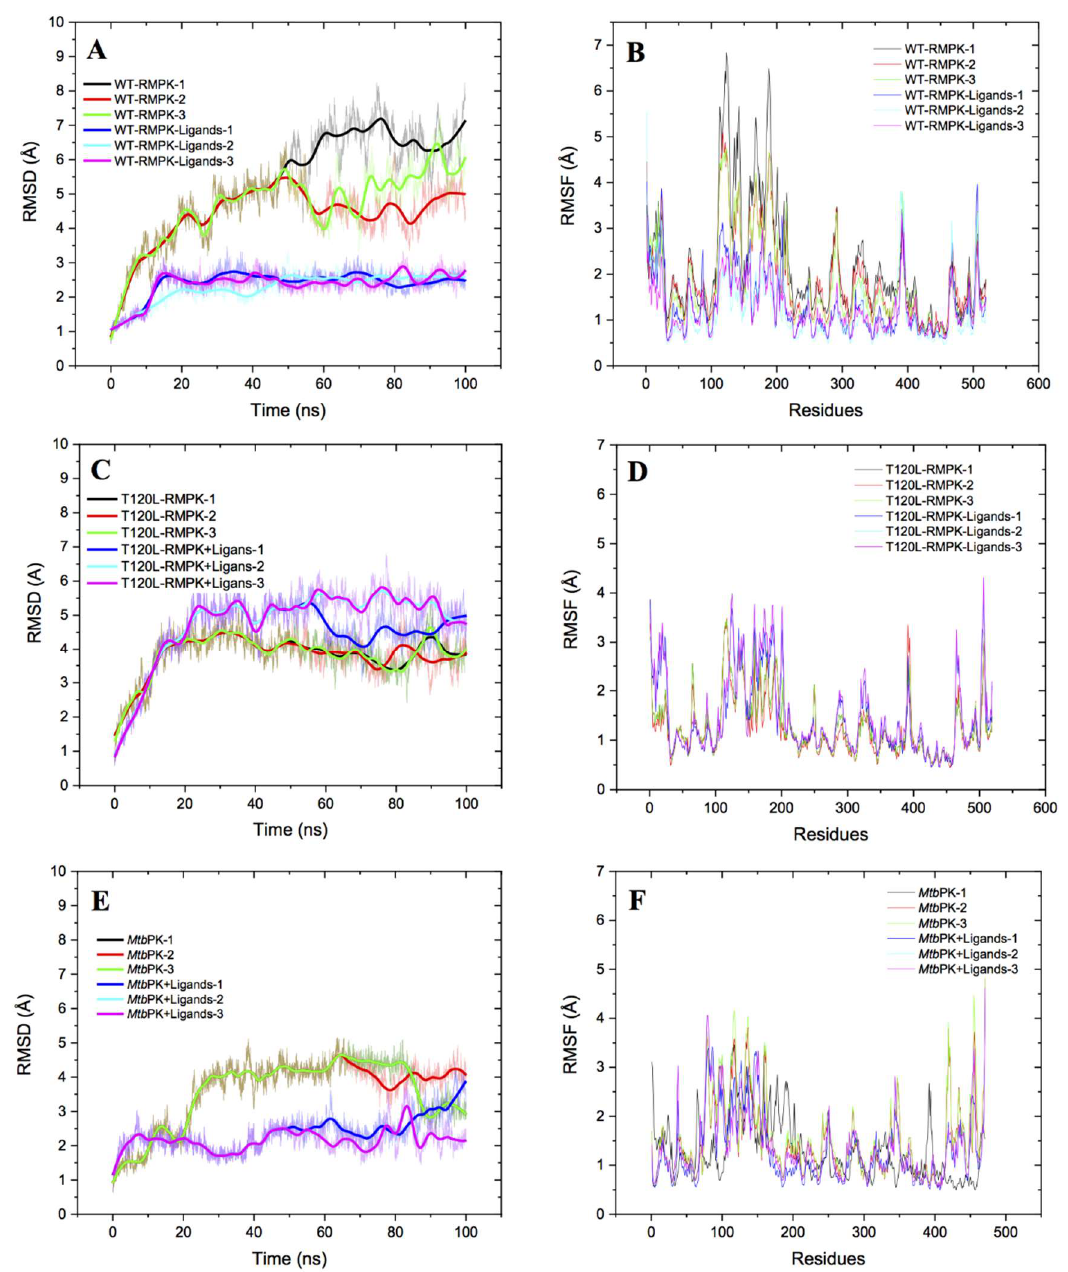
Figure 7. RMSD and RMSF from molecular trajectories of WT-RMPK ( A , B ), T120L mutant ( C , D ), and Mtb PK ( E , F ). Initial structures were in the presence of Mg 2+ , PEP, Mg-ADP and K + for the K + -dependent WT-RMPK and T120L mutant and without K + for the K + -independent Mtb PK. The presence or absence of ligands are indicated by different colors in ( A , C , E ), whereas red and blue lines indicated with and without ligands in ( B , D , F ). Triplicates of molecular dynamics were carried out and the analyzes were made with CPPTRAJ [32]. For the particular case of Mtb PK, runs 1 and 2 overlapped, either with or without ligands ( E